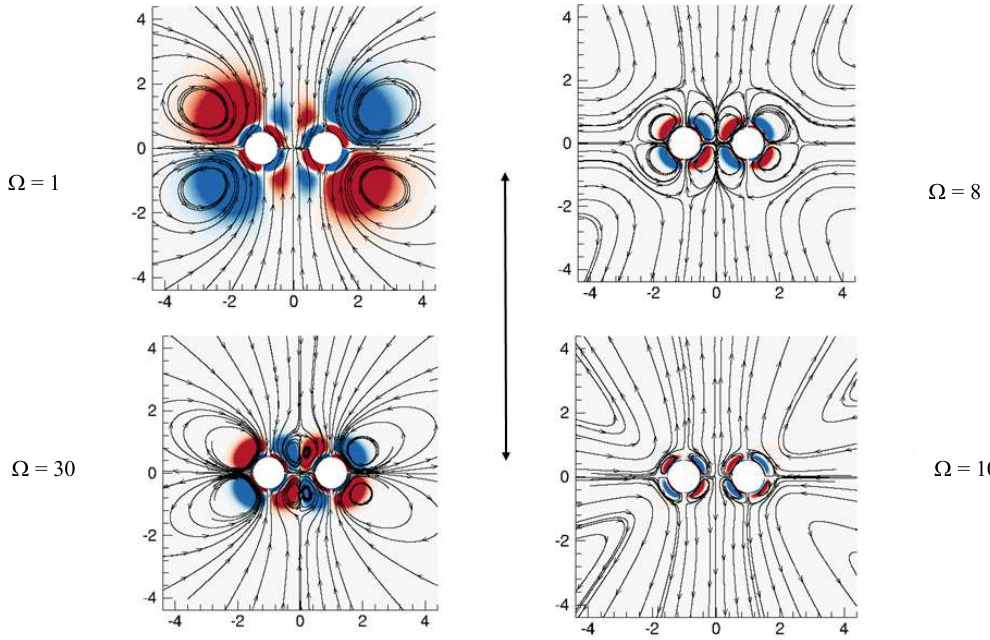
Figure 5. Microstreaming around two spheres placed in a lateral configuration when the distance between the two spheres is 2D, where D is the diameter of each sphere. The imposed flow is oscillating in the direction of the bold black arrow. Colour represents azimuthal component of vorticity −0.01 (blue) to 0.01 (red).